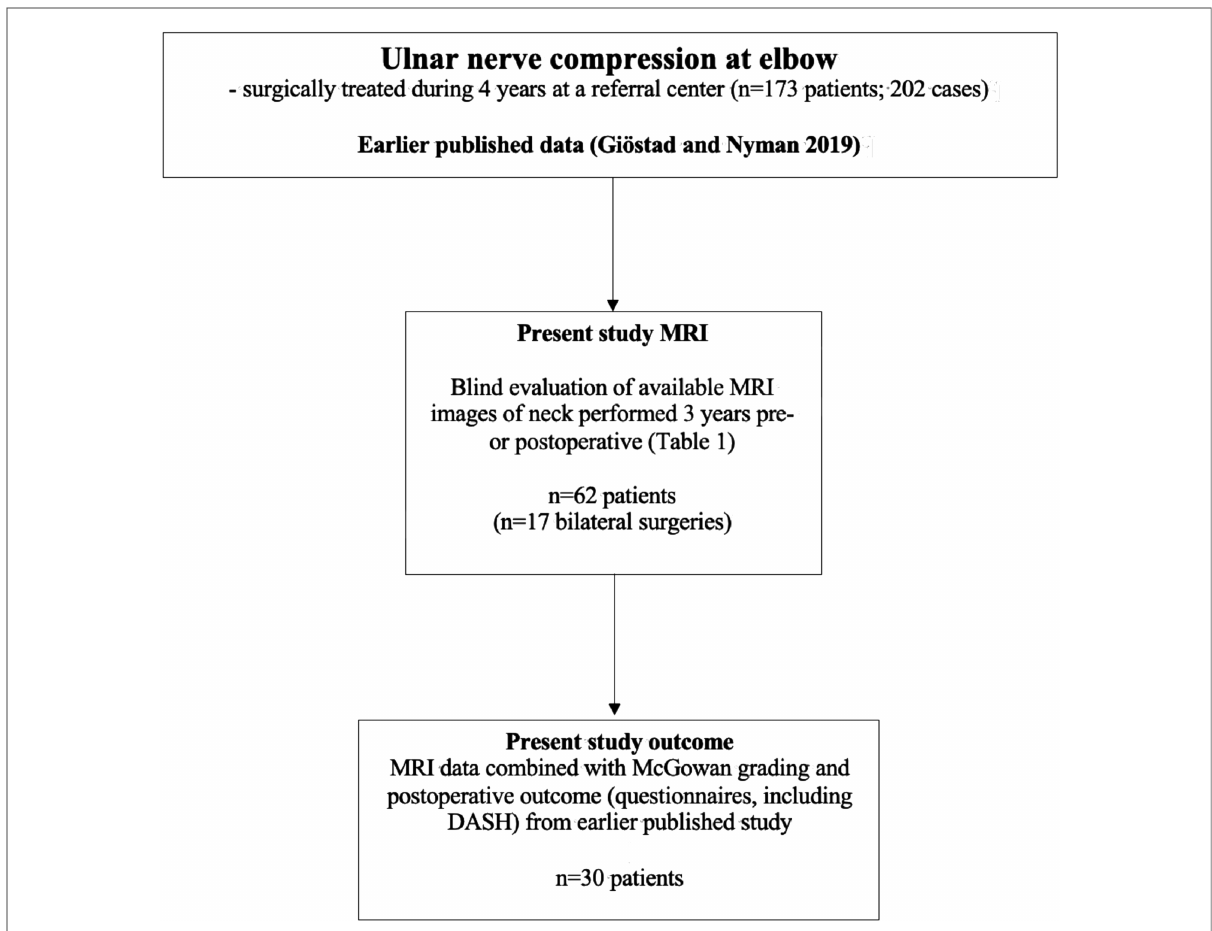
FIGURE 1 Flow chart of included patients in relation to previously published study of surgically treated patients (19). For variables, please see Table 1